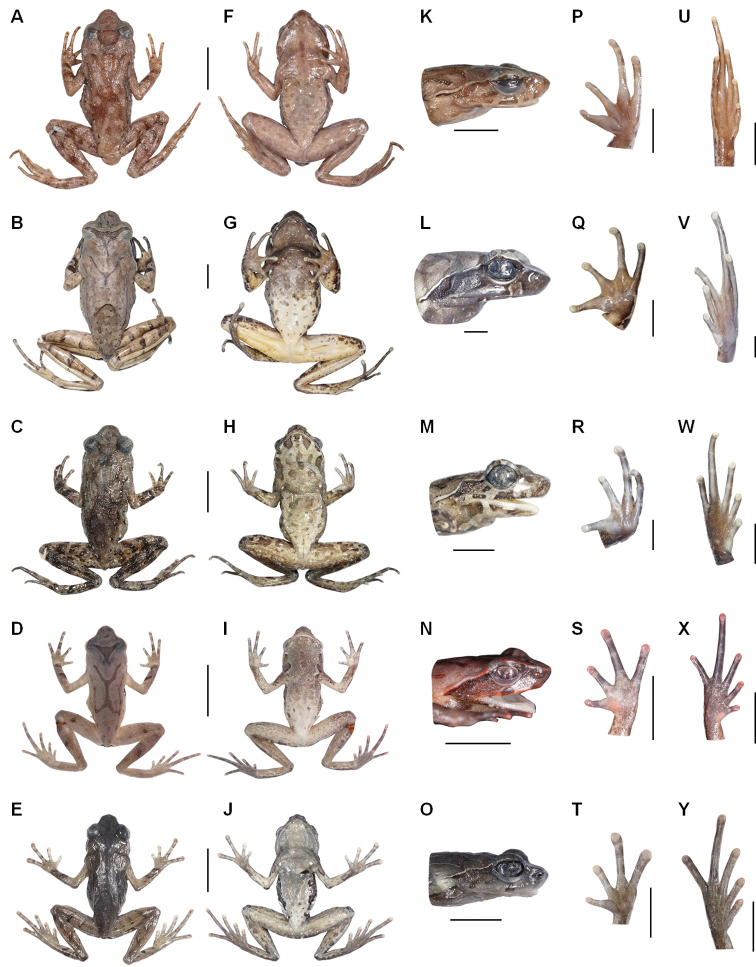
Photos of specimens of Megophrys species in Medog. A–E dorsal views of adult male holotype NWIPB770650 of M.
pachyproctus, adult male topotype CIB022017061406 of M.
medogensis, adult male CIB022017061805 of M.
cf.
pachyproctus, adult male holotype CIBMT171053 of Megophrys
zhoui sp. nov., and adult male holotype CIB201706MT02 of Megophrys
yeae sp. nov., respectively F–J ventral views of the specimens, respectively K–O lateral view of head of the specimens, respectively P–T ventral view of hand of the specimens, respectively U–Y ventral view of foot of the specimens, respectively. Scale bar for body view equal to 10 mm, and for partial view 5 mm.